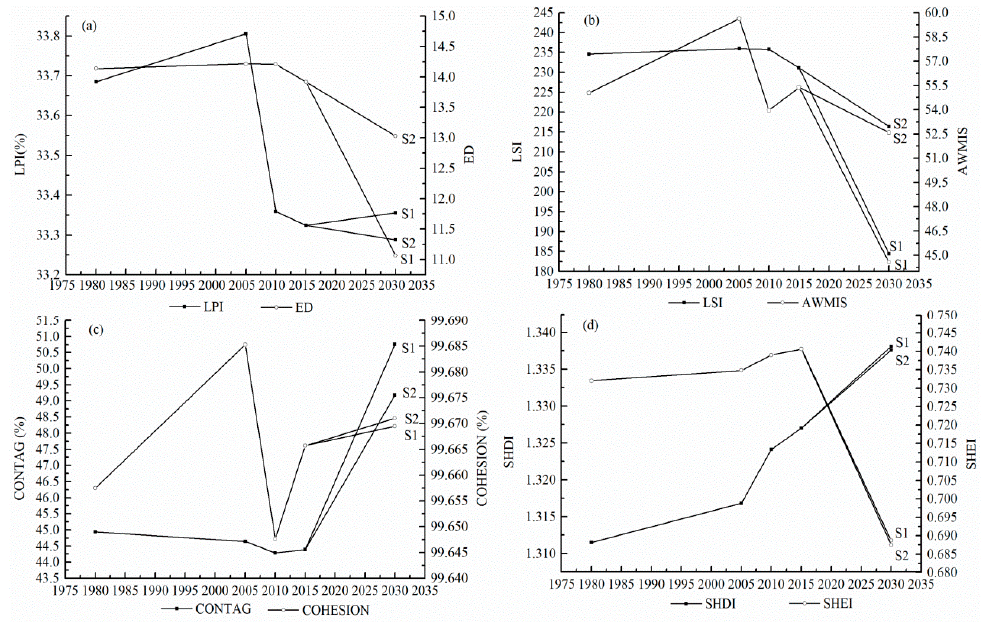
Figure 7. Landscape indices in Gansu Province: ( a ) area-edge indices; ( b ) shape indices; ( c ) landscape aggregation indices; ( d ) landscape diversity indices.